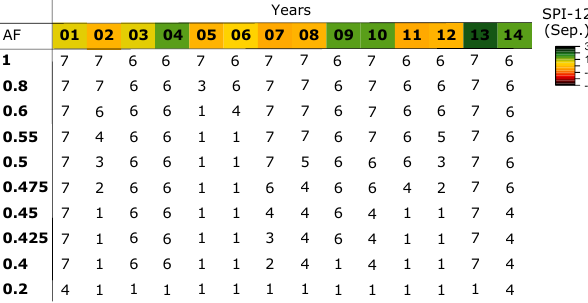
Table 2. Most profitable choice for the farmers for each of the years of the period 2001–2014 (represented in the columns) in function of the available water determined by the allocation factor (AF). The numbers of the options refer to the alternatives included in Ta- ble 1. The colours for the years represent the SPI-12 for the month of September for the catchment area of Barasona and Santa